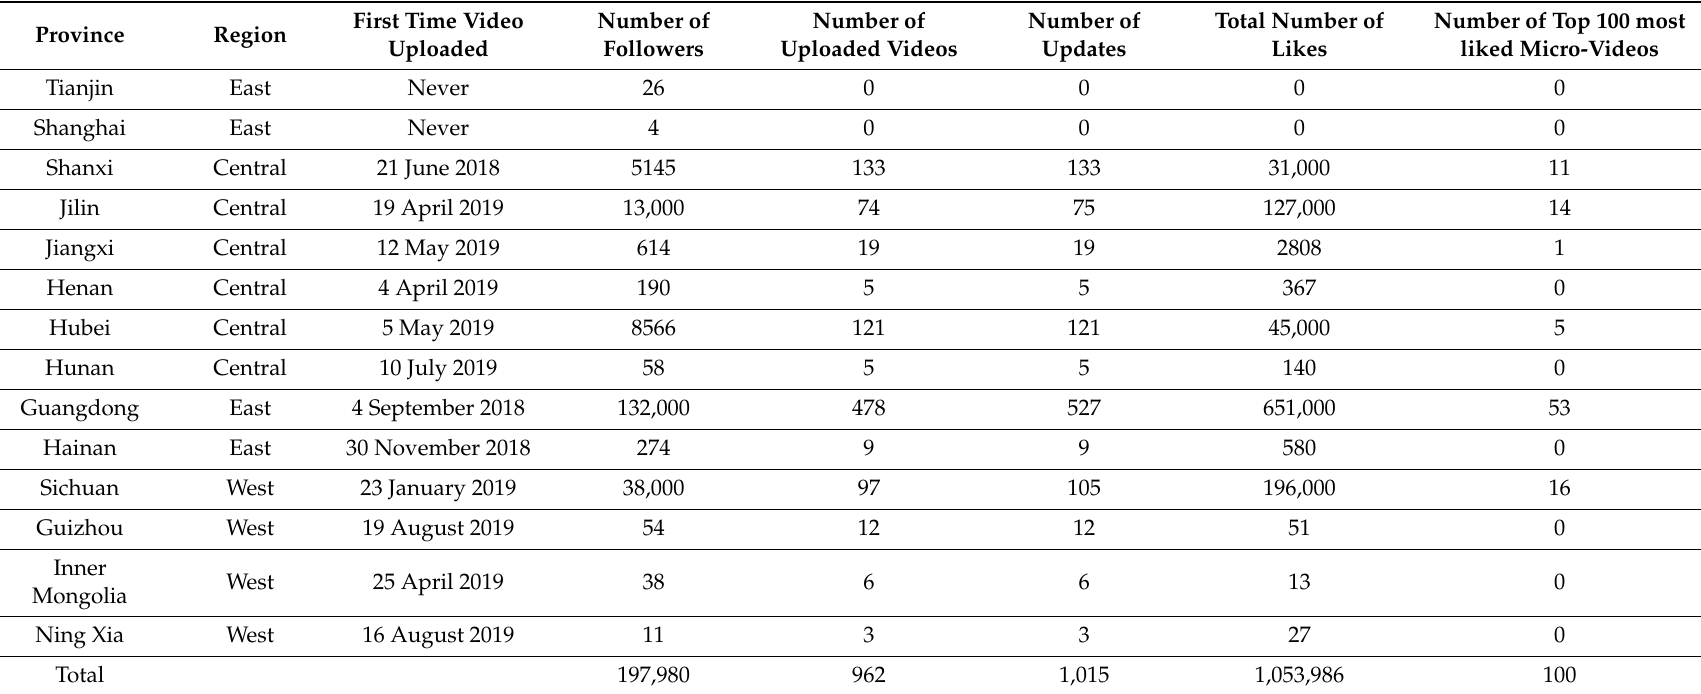
Table 2. Basic information of Tik Tok accounts run by